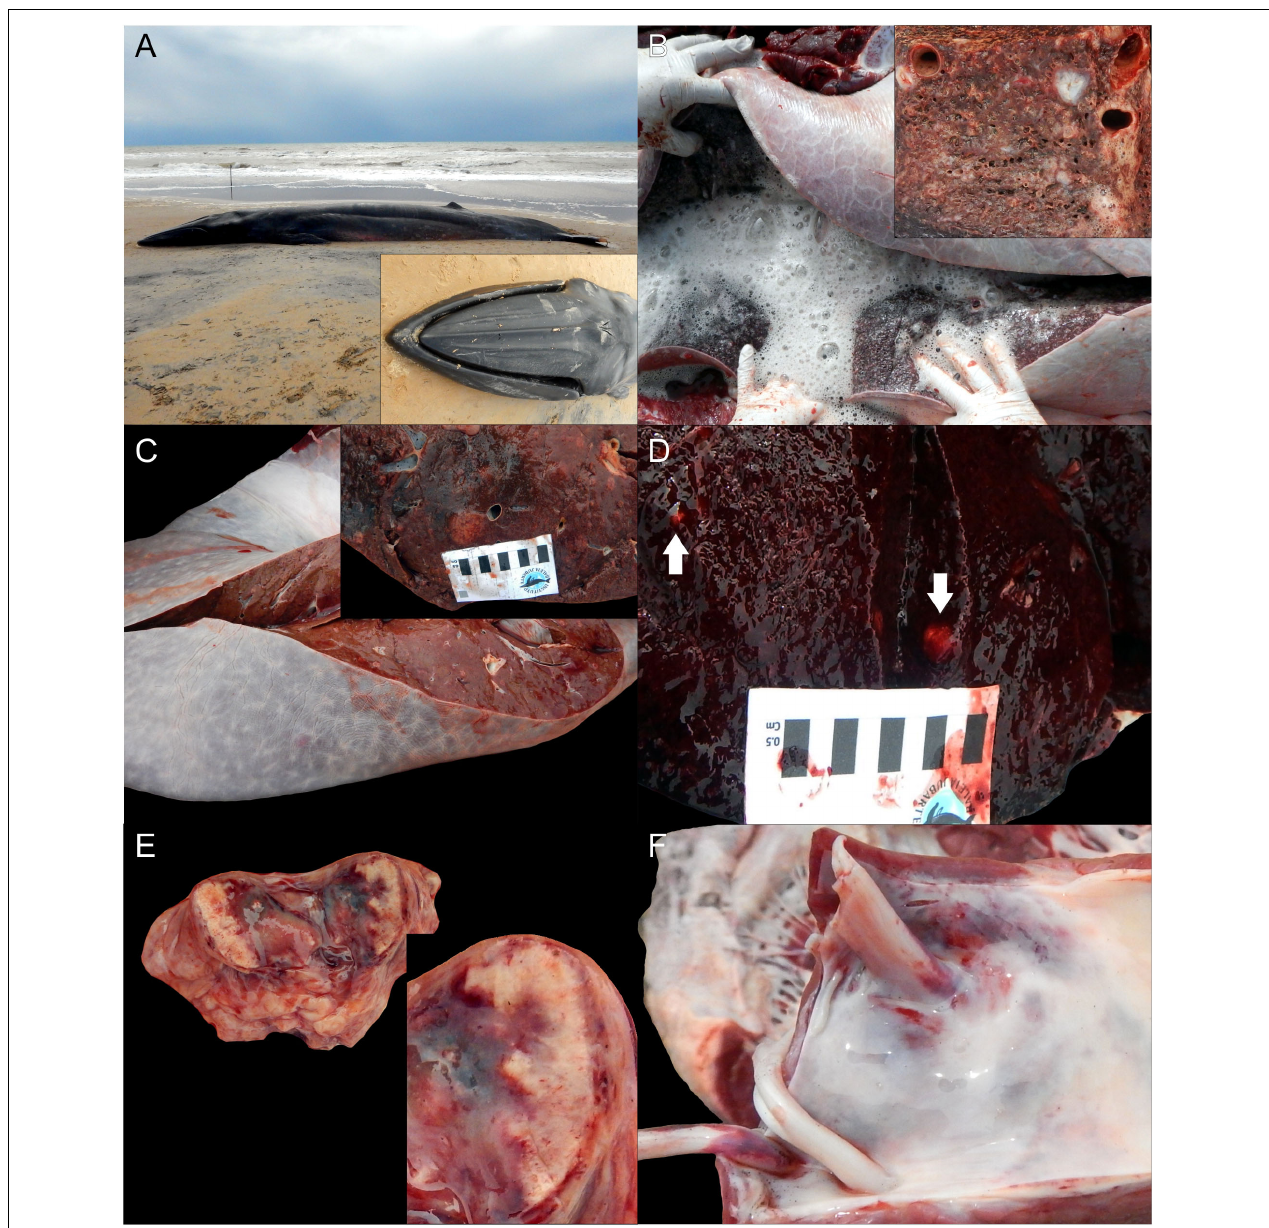
FIGURE 1 | Macroscopic findings in a Bryde’s whale ( Balaenoptera edeni ) with disseminated toxoplasmosis. (A) Whole body, left lateral view. Inset: characteristic three rostral cephalic ridges used as morphologic identification criterion. (B) Severe pulmonary edema. Inset: necrotizing interstitial pneumonia. (C) Necrotizing hepatitis. Inset: greater detail of necrotizing hepatitis. (D) Necrotizing splenitis. The arrows indicate the foci of necrosis. (E) Necrotizing lymphadenitis. Inset: greater detail of necrotizing lymphadenitis. (F) Endocardial hemorrhages.